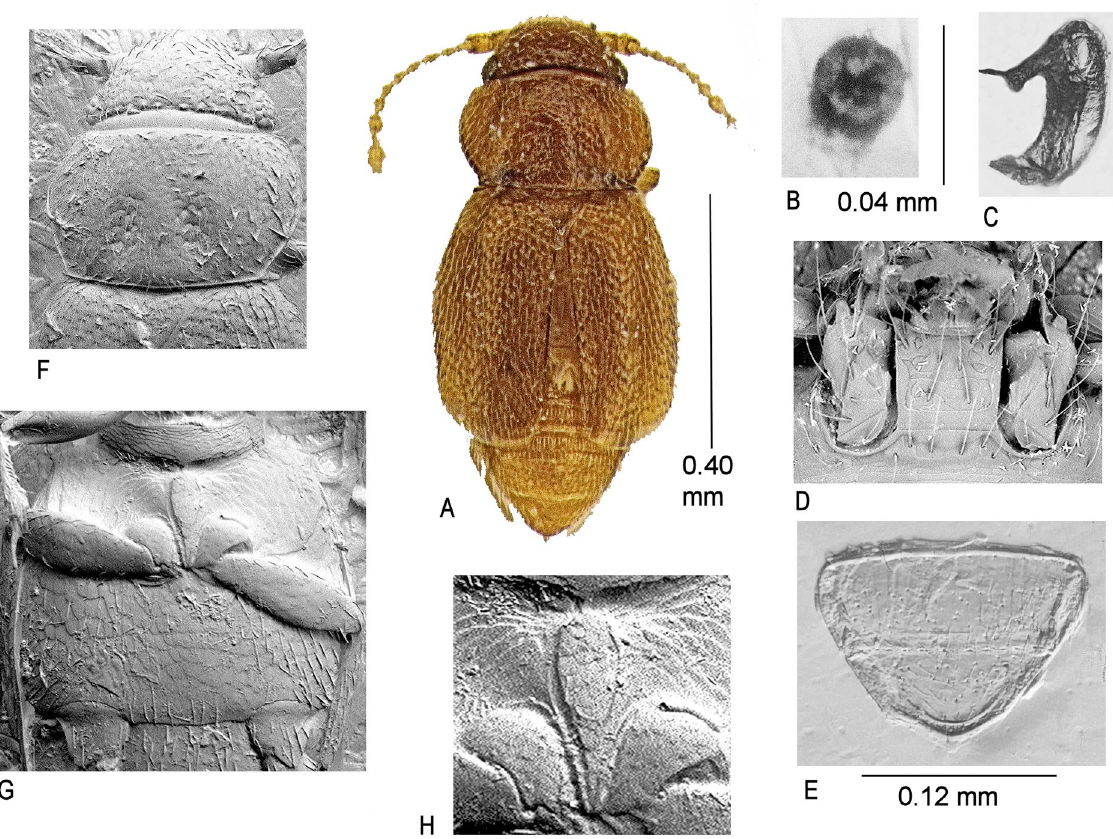
Fig. 12. Niptella gutta gen. et sp. nov. A . Habitus. B . Spermatheca. C . Aedeagus. D . Mentum and submentum ×860. E . Pygidium. F . Pronotum ×540. G . Meso- and metaventra ×470. H . Mesoventral keel